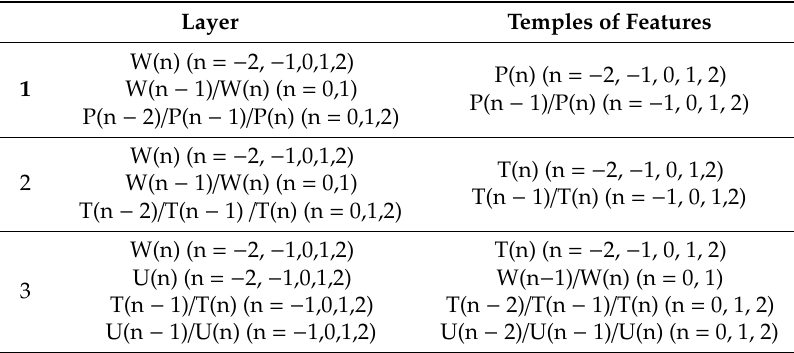
Table 6. Temples of cascaded conditional random field (CCRF) features. Layer